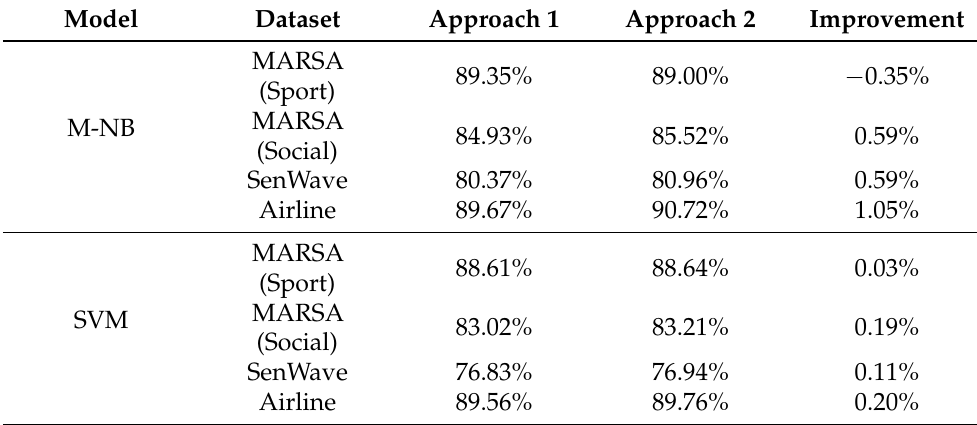
Table 15. Evaluation of the term classification